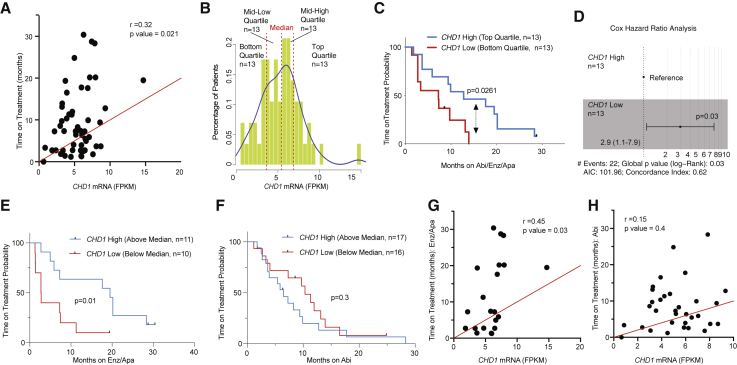
CHD1 mRNA Level Is Correlated with Clinical Outcome of Antiandrogen Treatment(A) Pearson correlation analysis of CHD1 mRNA and time of treatment on abiraterone (Abi)/enzalutamide (Enz)/apalutamide (Apa) of a 52 mCRPC patient cohort.(B) CHD1 expression distribution in all patients of the cohort in (A).(C) Probability of treatment duration of the top quartile compared with bottom quartile of all patients treated with abiraterone (Abi)/enzalutamide (Enz)/apalutamide (Apa); p value was calculated using Mantel-Cox test.(D) Cox hazard ratio analysis of the top and bottom quartile of all patients, p value was calculated using log rank test.(E) Probability of treatment duration of the above median compared with below median of patients who received enzalutamide (Enz)/apalutamide (Apa), p value was calculated using Mantel-Cox test.(F) Probability of treatment duration of the above median compared with below median of patients who received abiraterone (Abi), p value was calculated using Mantel-Cox test.(G) Pearson correlation analysis of CHD1 mRNA and time of treatment on patients who received enzalutamide (Enz)/apalutamide (Apa), n = 21 (2 patients received both apalutamide and abiraterone).(H) Pearson correlation analysis of CHD1 mRNA and time of treatment on patients who received abiraterone (Abi), n = 33.